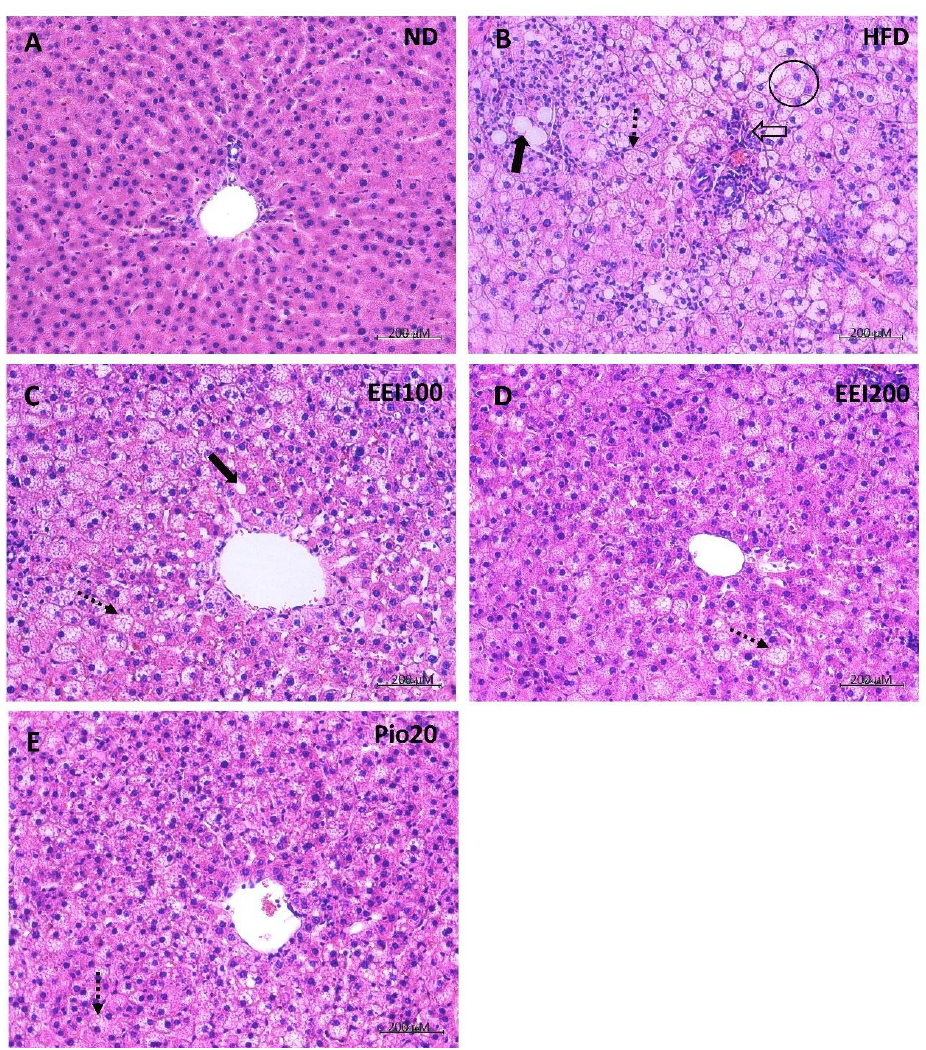
Figure 5. The effect of 2-week feeding EEI on macroscopic liver appearance. ND = Normal diet-fed rats treated with vehicle; HFD = High fat diet-fed rats treated with vehicle; EEI100 = HFD-fed rats treated with 100 mg/kg/day of EEI; EEI200 = HFD-fed rats treated with 200 mg/kg/day of EEI; Pio = HFD-fed rats treated with 20 mg/kg/day of pioglitazone.